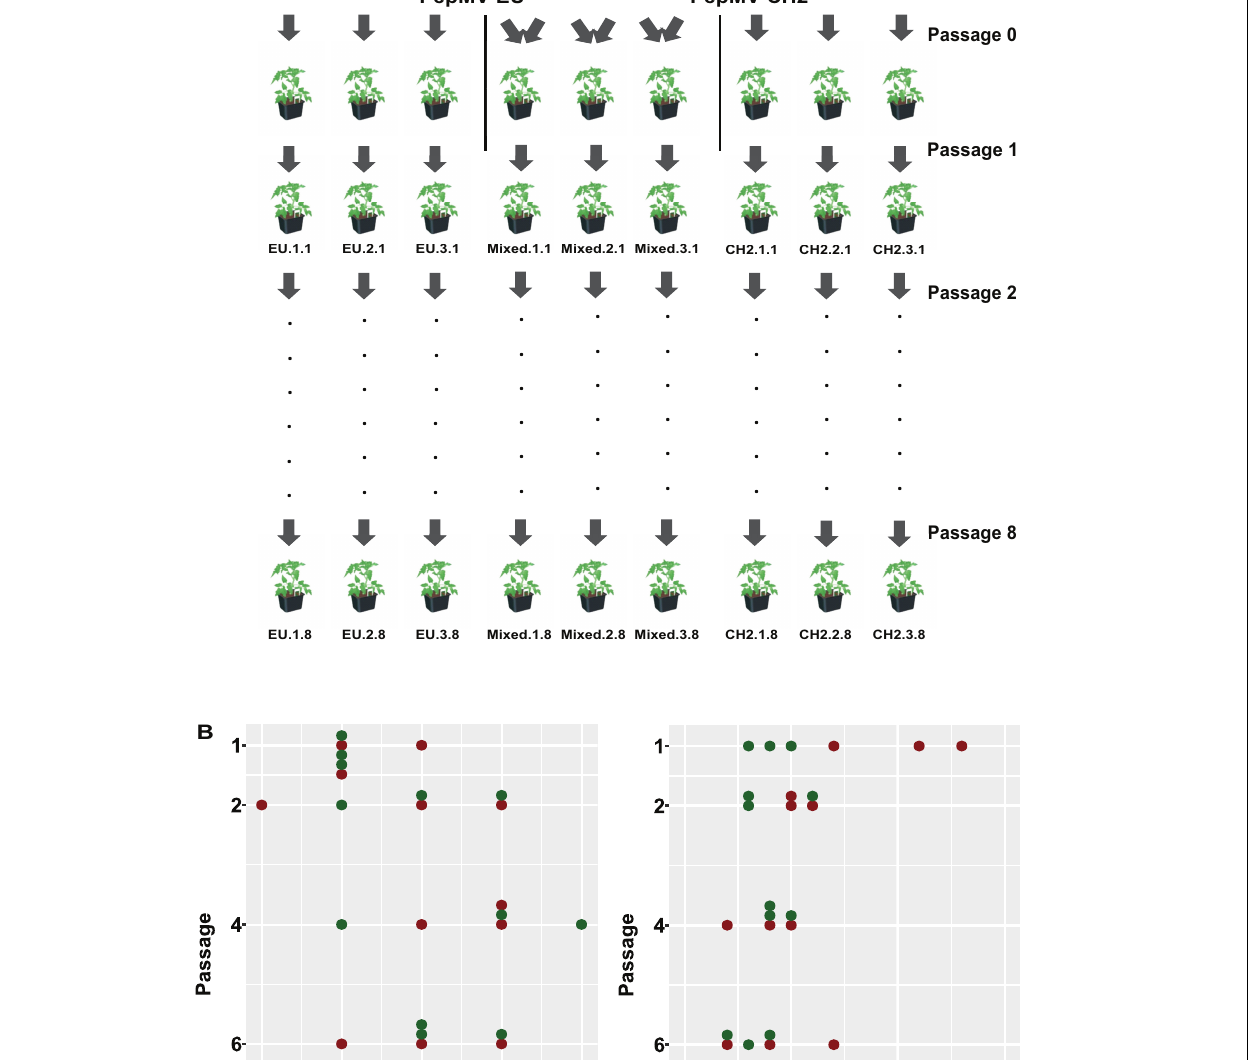
pre-inoculations with just one mild isolate may not confer full protection; in this regard, it is probably safer to pre-inoculate with a mixture of isolates of the two strains, as